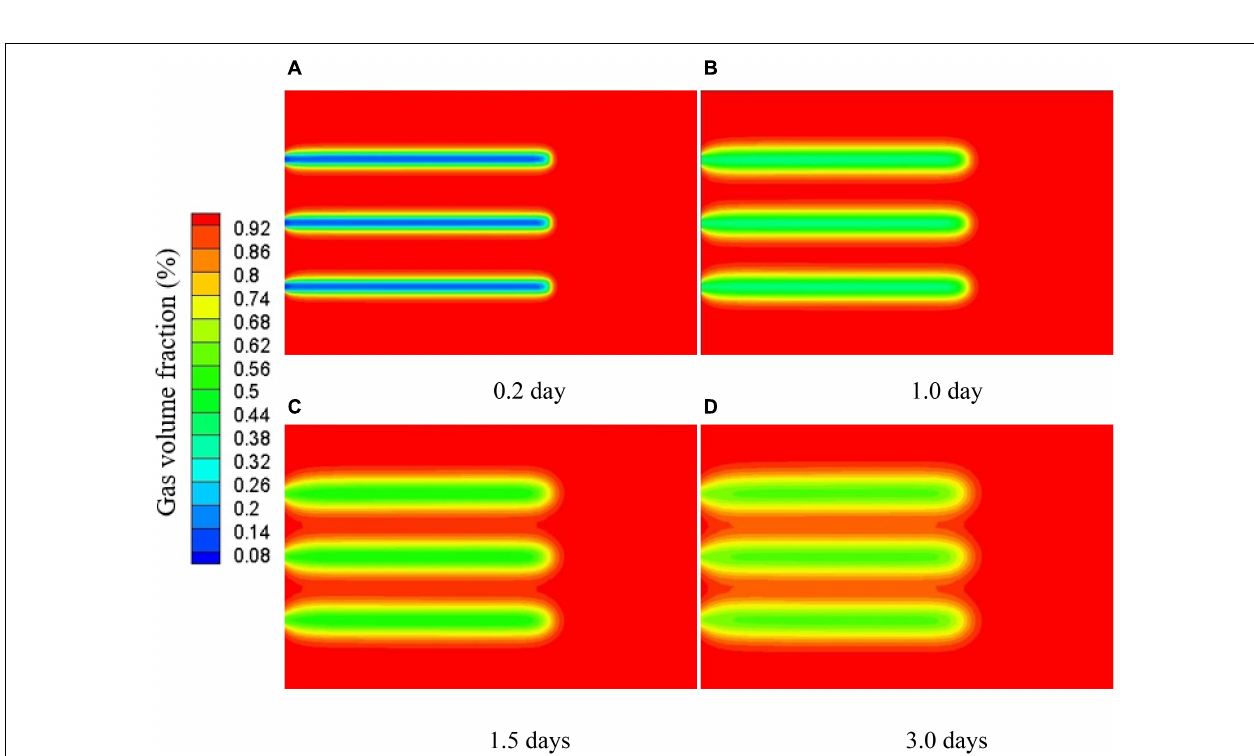
FIGURE 11 | Gas seepage fields of a 3-m slotted coal seam when λ = 0 . 1: (A) 2 day, (B) 1 day, (C) 1.5 days, and (D) 3 days.